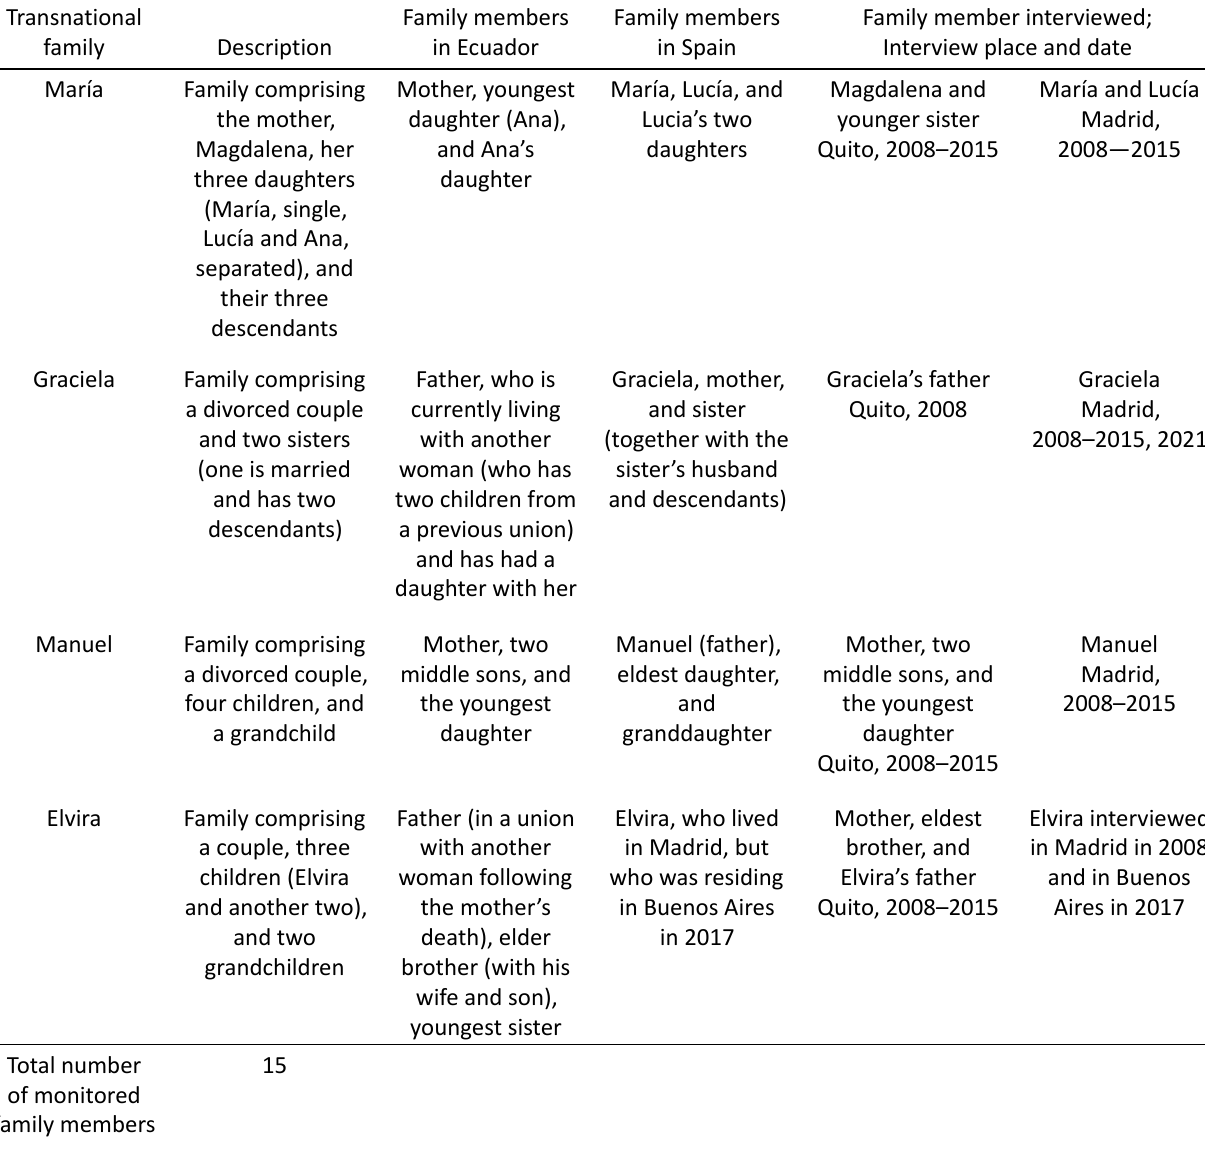
Table 1. Description of the transnational families